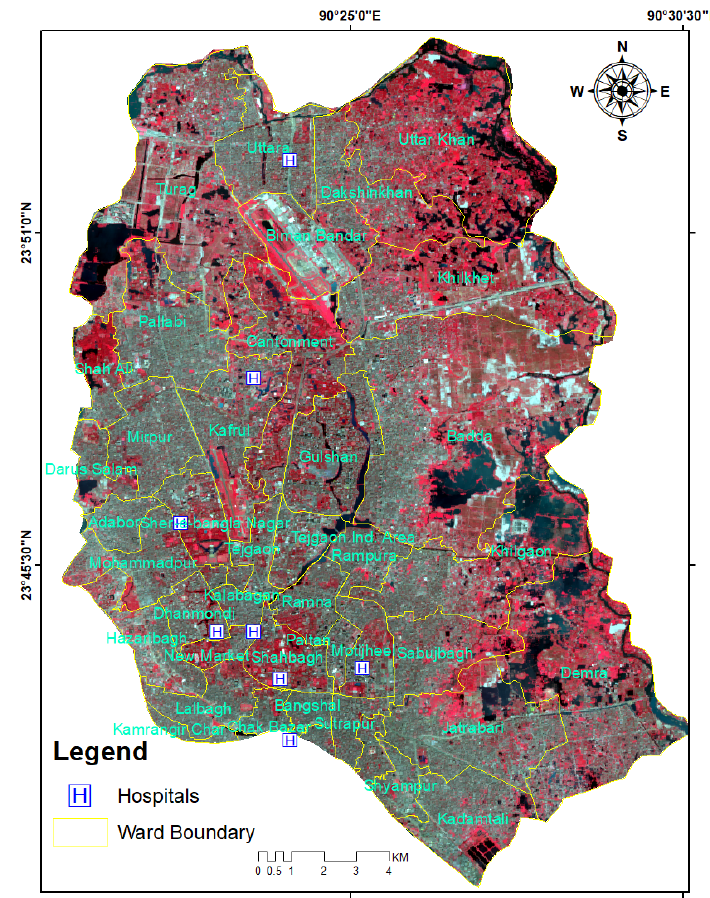
Figure 1. Location of the study area, Dhaka City, Bangladesh (Background image: Landsat 8, 2021: a false color combination map of infrared-band red and green in red, green, and blue colors, where the reddish region indicates vegetated area, gray color urban or built-up area, and dark blue for the water bodies).